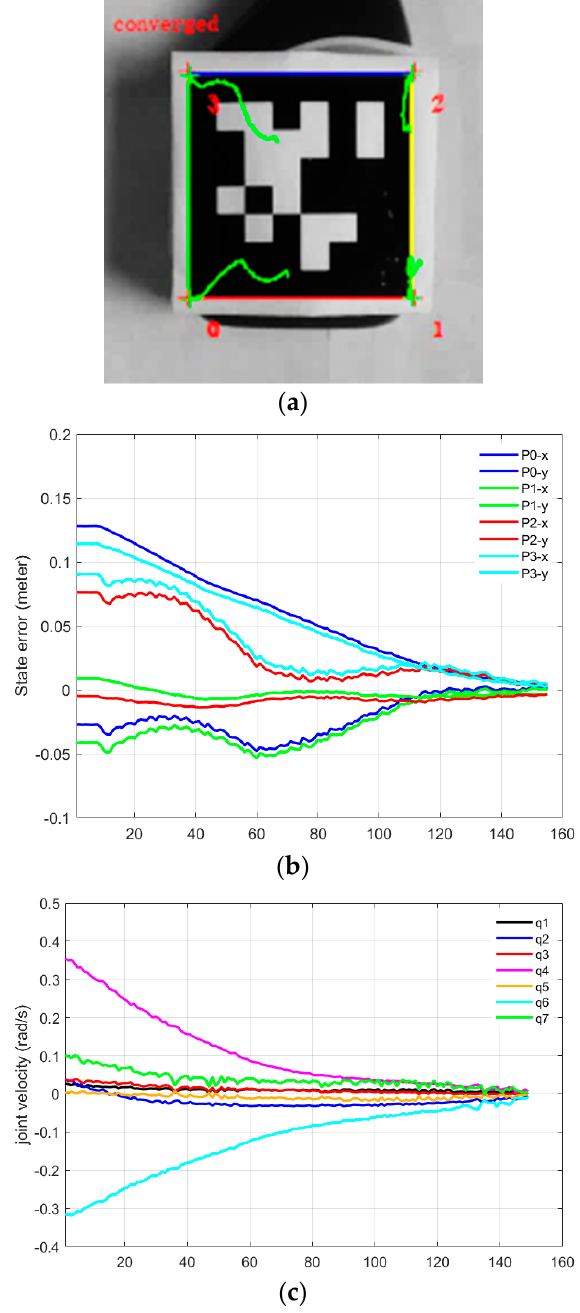
Figure 13. Visual servoing in the joint space using mix frame velocity and mix frame Jacobian ( a ) feature trajectory in the image plane, ( b ) visual feature error decay, ( c ) joint velocities.